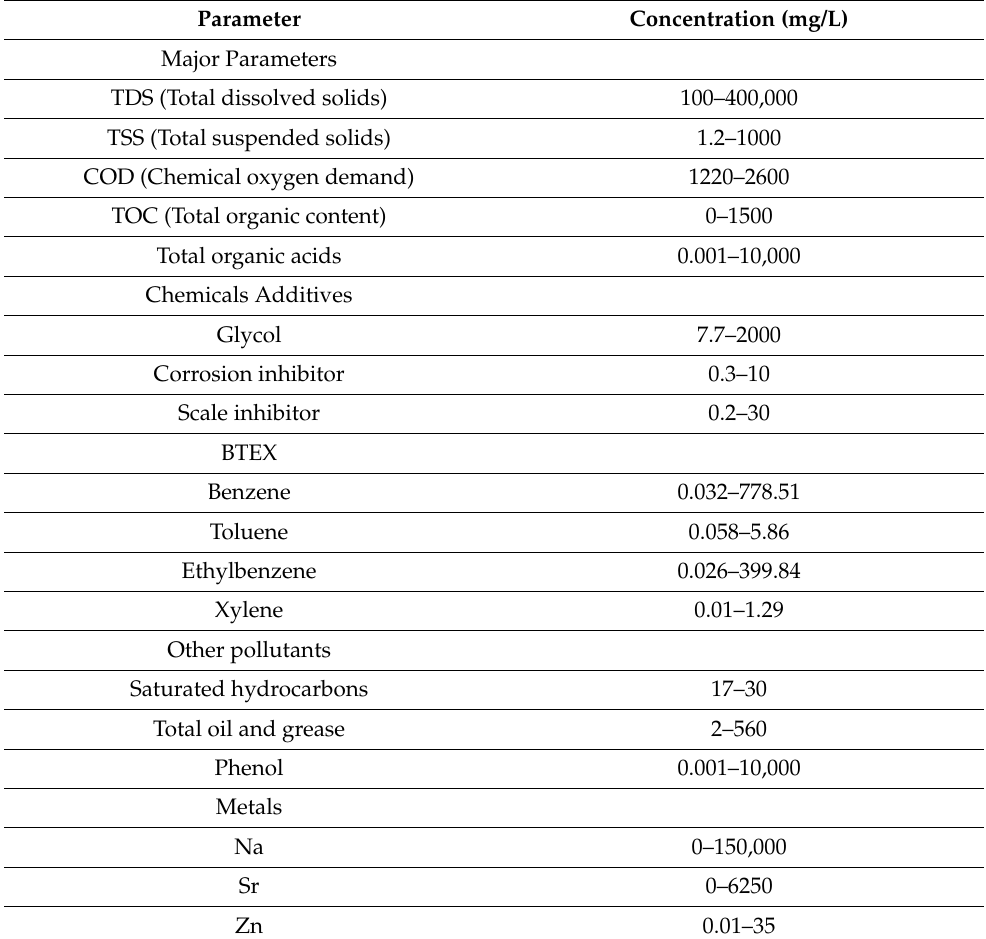
Table 1. Generic PW Composition [18]. Reprinted with permission from ref [18]. 2019